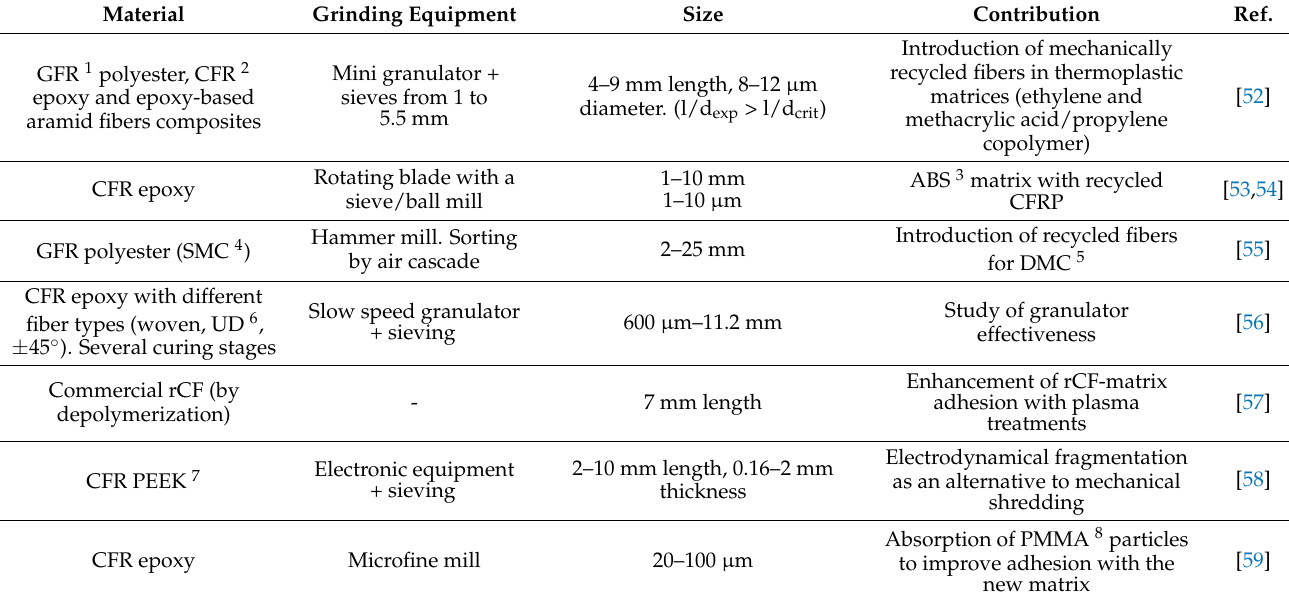
Table 1. Mechanical recycling methods.